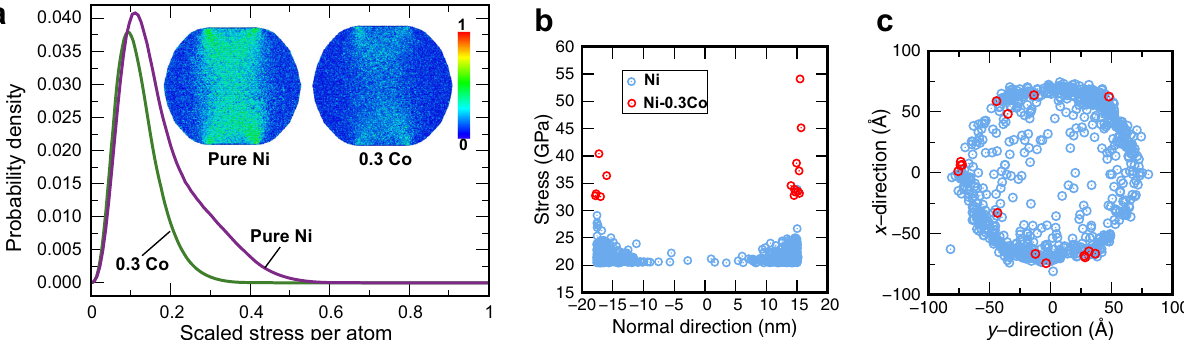
Fig. 8 Characterization of stresses in nanoparticles under compression. a MRAS distribution scaled by the min-max formula (1) in 35 nm particles of pure Ni and Ni-0.3Co. The inset shows the min – max scaled MRAS distributions in the particle cross-sections. b MRAS in the particles as a function of the z -coordinate normal to the substrate ( z = 0 at the particle center). Only the high end of the MRAS distribution is shown for clarity. c Positions of the points shown in ( b ) in the top view of the particle. The hexagon shape corresponds to the top (111) facet. Note that the highest MRAS values are reached in the Ni-0.3Co particle and are concentrated at the facet edges